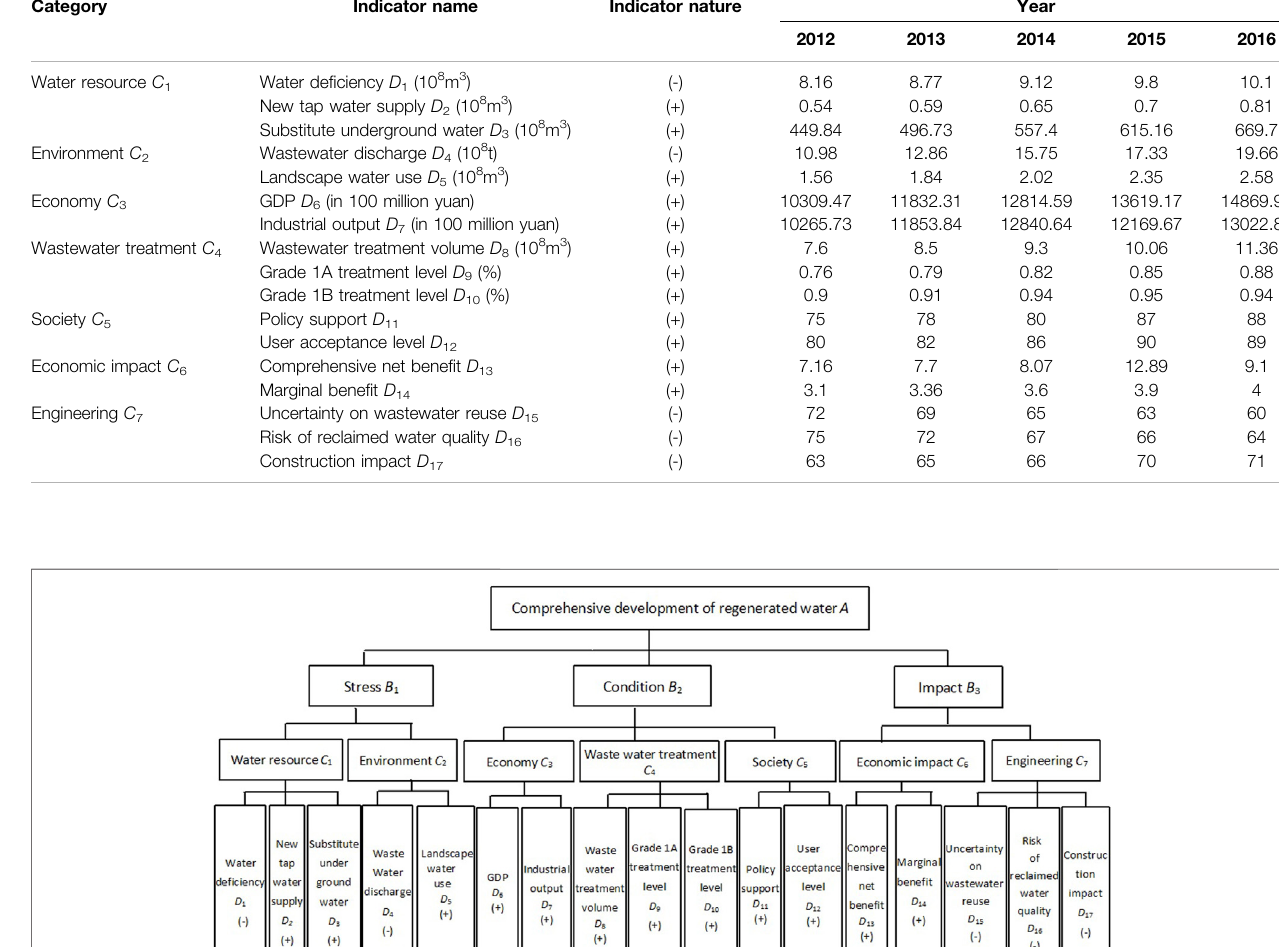
Frontiers in Environmental Science |